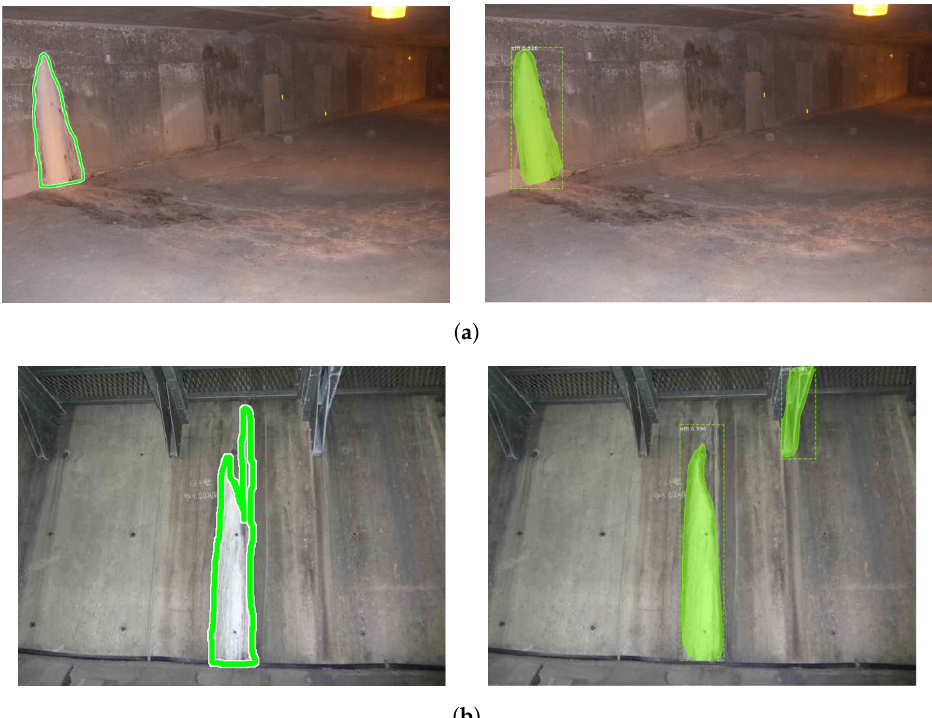
Figure 6. Examples of efflorescence detection results (left column: original images with ground truth, right column: detection result of trained Mask R-CNN): ( a ) detection result of Efflorescence-5 in Table 1, and ( b )detection result of Efflorescence-3 in Table